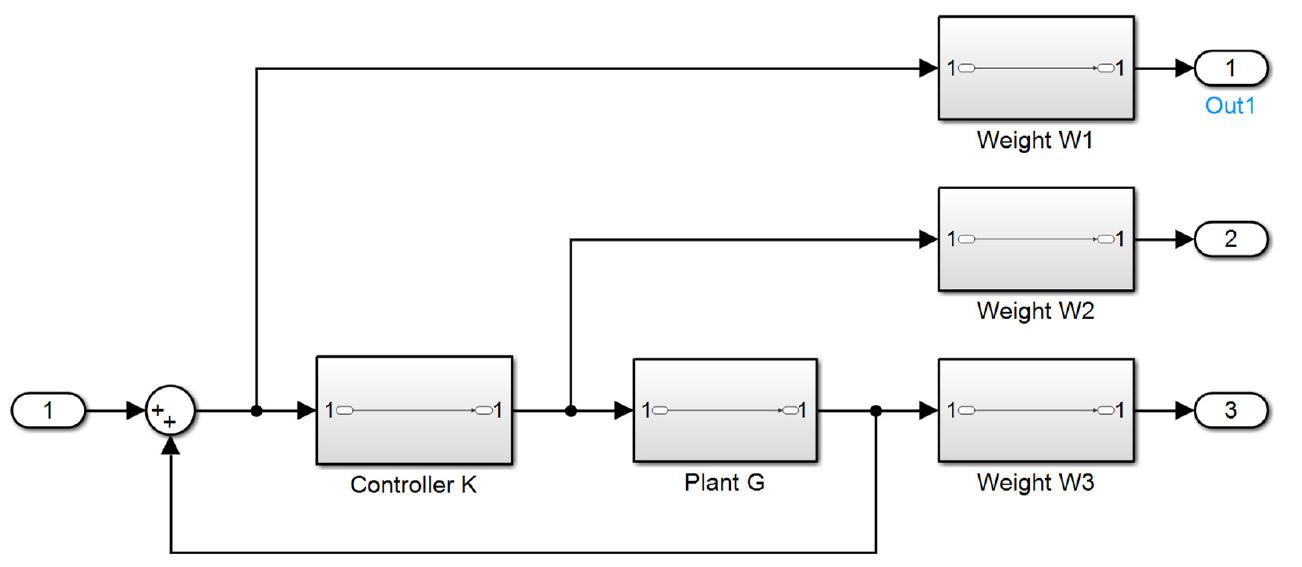
Figure 3. The Control Problem for Mixed Sensitivity Loop Shaping.